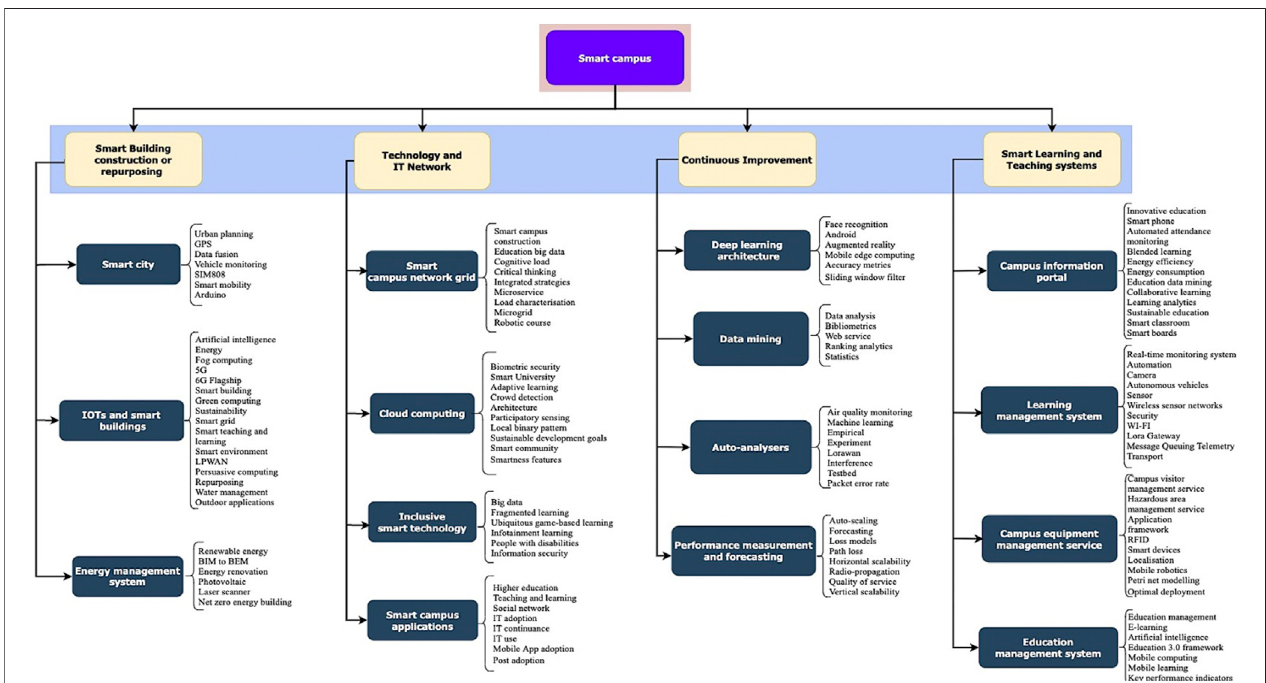
FIGURE 1 | Elements of a smart campus infrastructure (Source: Omotayo et al., 2021).